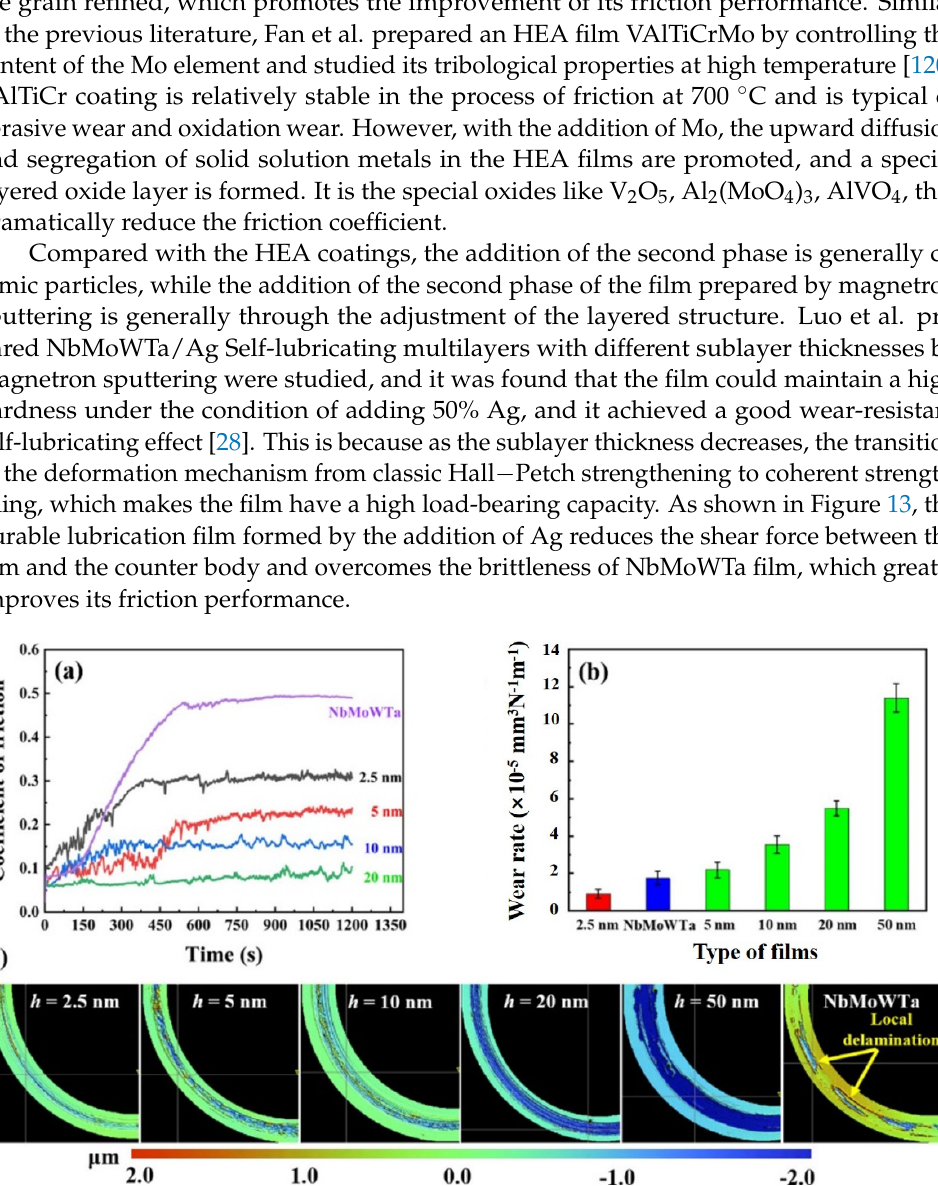
Figure 13. The tribological properties and surface profile of all the NbMoWTa/Ag multilayers and monolithic NbMoWTa film. ( a ) COF and ( b ) wear rate of different films. ( c ) White light interferometry images of the worn surfaces [28].